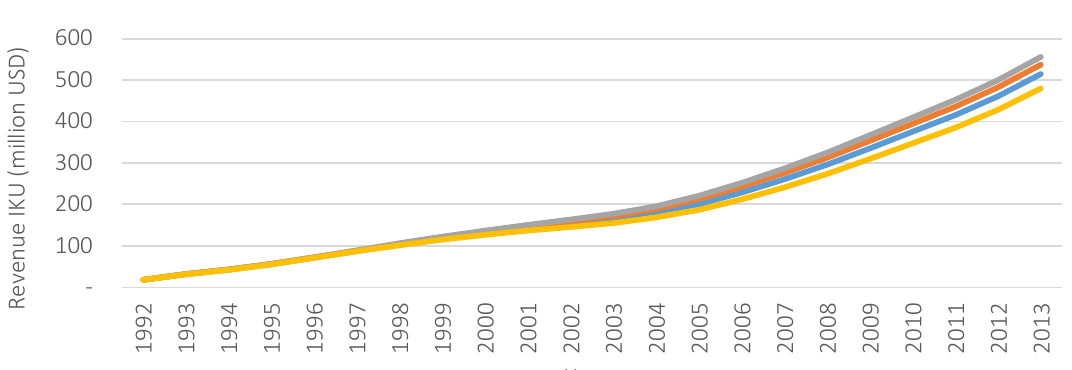
Figure 9. Simulation of symbiosis model of IKA to revenue